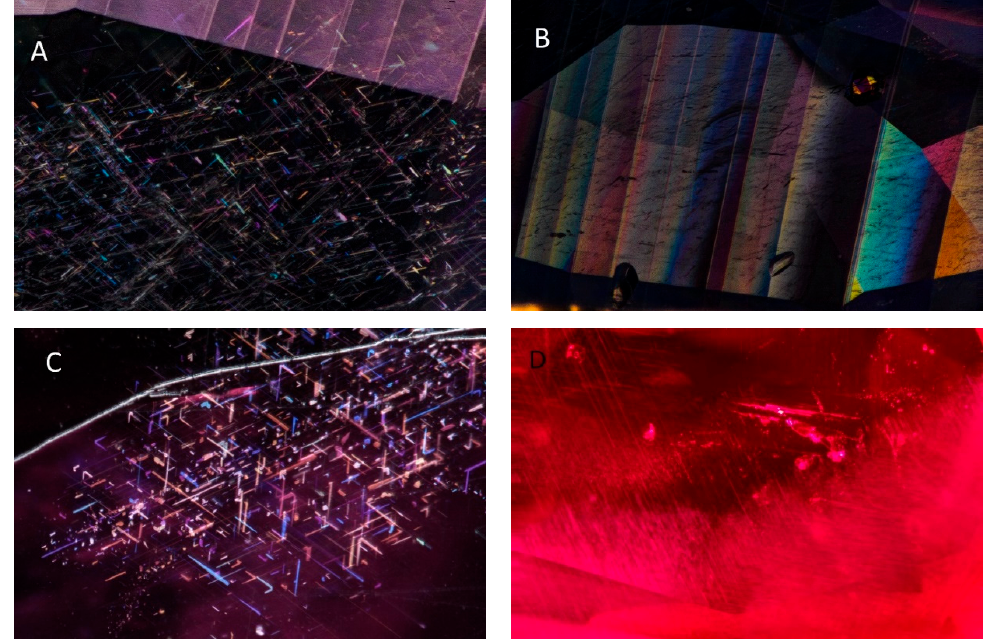
Figure 4. Photomicrographs of characteristic inclusions in Mogok, Myanmar, ( A , B ) blue sapphires showing reflective oriented rutile silk and polysynthetic twinning and ( C , D ) rubies including ( C ) reflective, oriented rutile silk and ( D ) nested elongate rutile silk surrounding mineral inclusions. Photomicrographs by ( A , B , D ) Aaron C. Palke and ( C ) Charuwan Khowpong. Fields of view: ( A ) 3.57 mm, ( B ) 2.34 mm, ( C ) 1.58 mm, and ( D ) 4.48 mm.